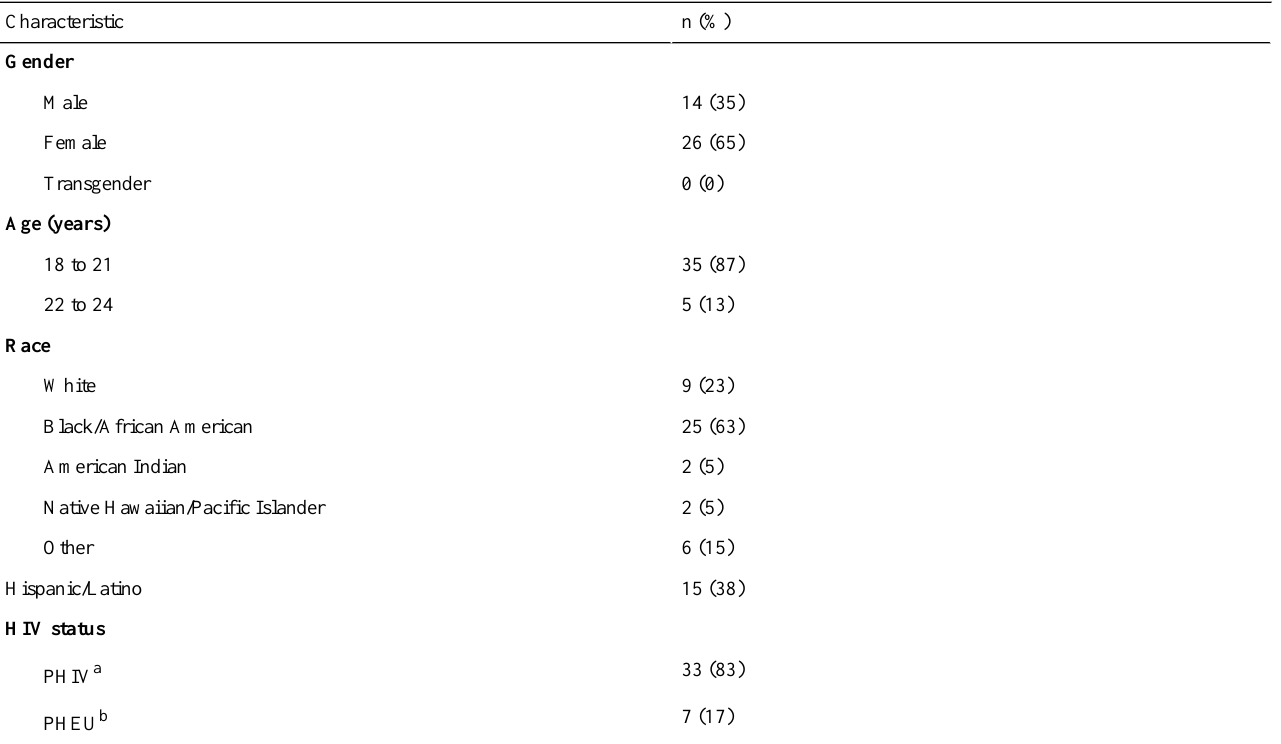
Table 1. Selected participant characteristics